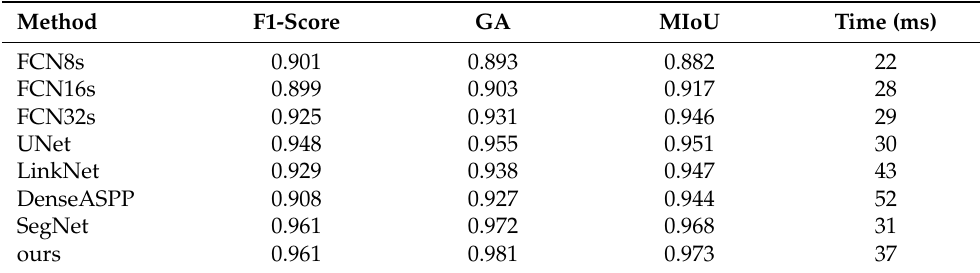
Table 2. Comparison with mainstream segmentation models on fish